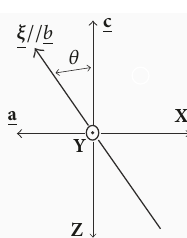
Figure3:Orientation 𝜉 ofthe( a + c )screwTD.Theinclinationangle 𝜃 is 31.5 ∘ .